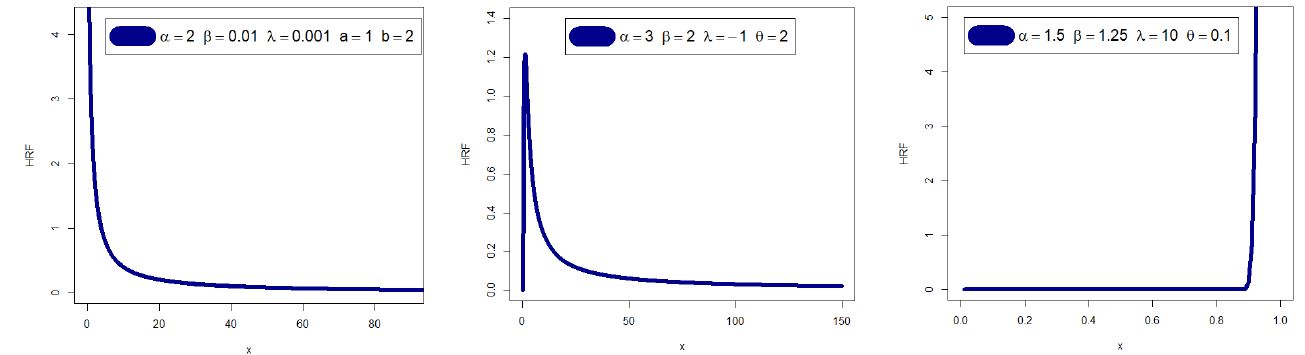
Figure 2. Graphs of the EGRRP HRF for selected parameter values.